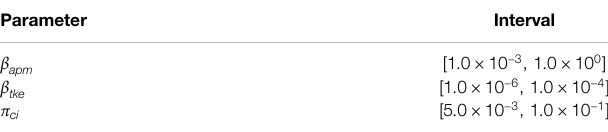
TABLE 3 | Bounds used for parameters calibration of the COVID-19 model for non-survivors. Parameter Interval